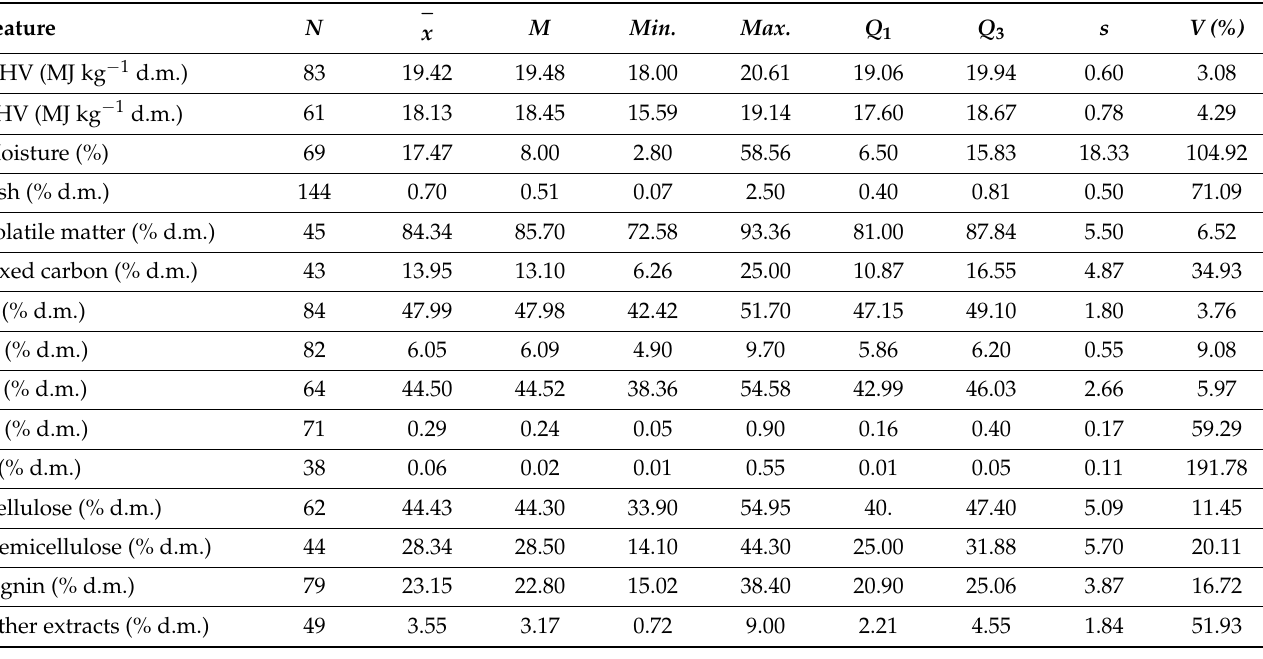
Table 3. Differentiation of the thermophysical properties and composition of deciduous wood.